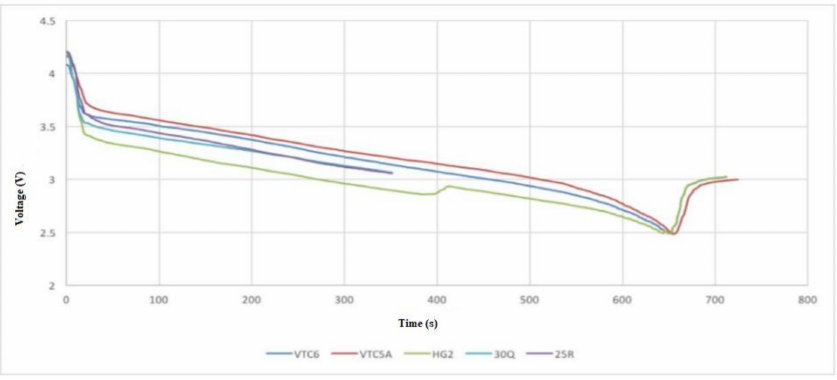
Figure 8. Single cell tests: voltages from 15 A discharge with active air cooling.